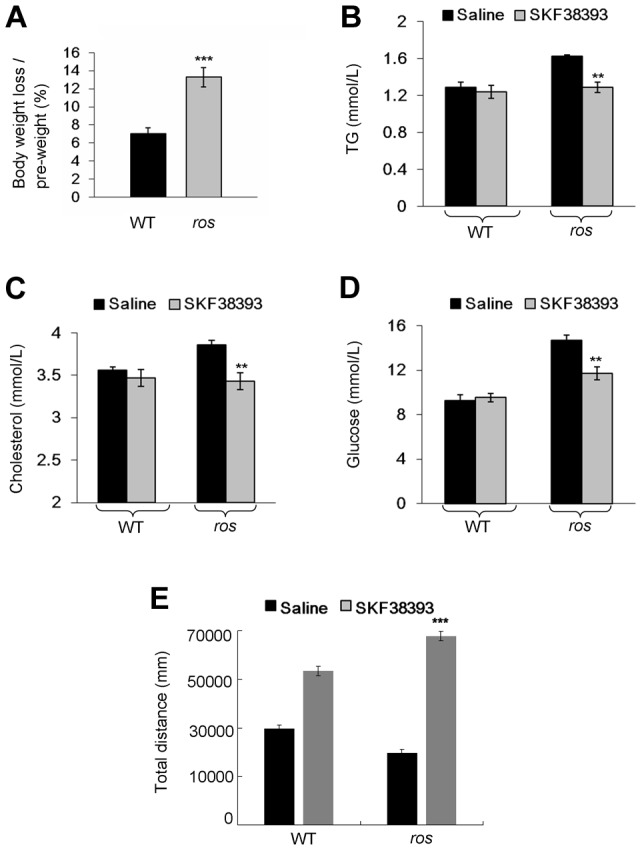
Effect of SKF38393 treatment on body weight loss, serum lipids and glucose, and activity of wild-type or ros mice.Mice at 24 weeks of age were used in this study. (A) Wild-type (WT) or ros mice (n = 9 per group) received a daily intraperitoneal injection of 20 mg/kg SKF38393 for 12 days and weighed on day 14. Body weights of saline-treated WT or ros mice had no significant changes, whereas body weights of SKF38393-treated WT mice were reduced approximately 7% (from 29.61±0.76 g to 27.5±0.6 g), and body weights of SKF38393-treated ros mice were reduced approximately 13% (from 38.56±0.79 g to 33.39±0.58 g). ***P<0.001. (B–D) Compared with saline-treated WT mice (n = 8), SKF38393-treated WT mice (n = 9) exhibit no significant changes of serum levels of triglycerides (TG), cholesterol (Chol) and blood glucose (Gluc). In SKF38393-treated ros mice, serum levels of Chol, TG and Gluc were significantly reduced compared to saline-treated ros littermates. SKF38393 vs. saline, Chol: 3.43±0.08 mmol/L (n = 9) vs. 3.86±0.05 mmol/L (n = 7); TG: 1.29 ± 0.06 mmol/L (n = 8) vs. 1.63±0.01 mmol/L (n = 7); Gluc: 11.7±0.57 mmol/L (n = 9) vs. 14.67±0.46 mmol/L (n = 7). **P<0.01. (E) Total distances traveled during the period of 30 min to 60 min after SKF38393 treatment were increased in both WT and ros mice. However, the distance traveled in ros mice was greater than that in WT (***P<0.001).